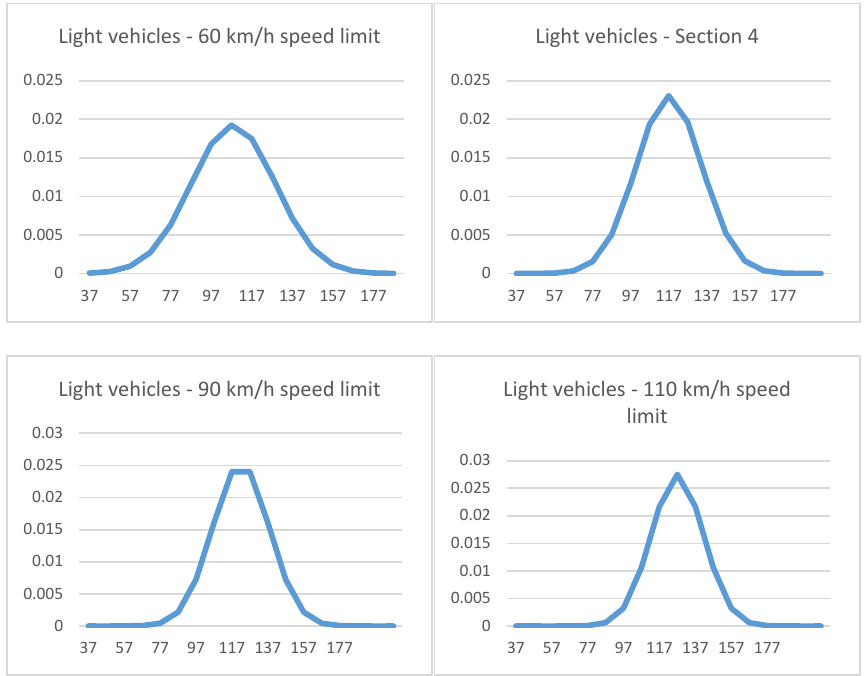
Figure 4. Desired speed distributions at various sections upstream the roadworks .